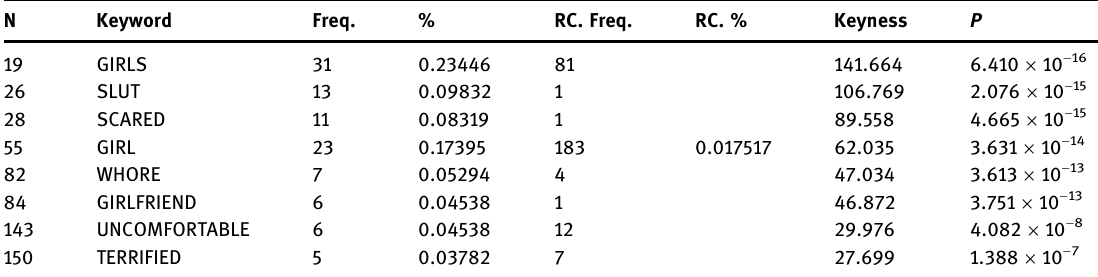
Table 20: Keywords used for naming and describing the victims N